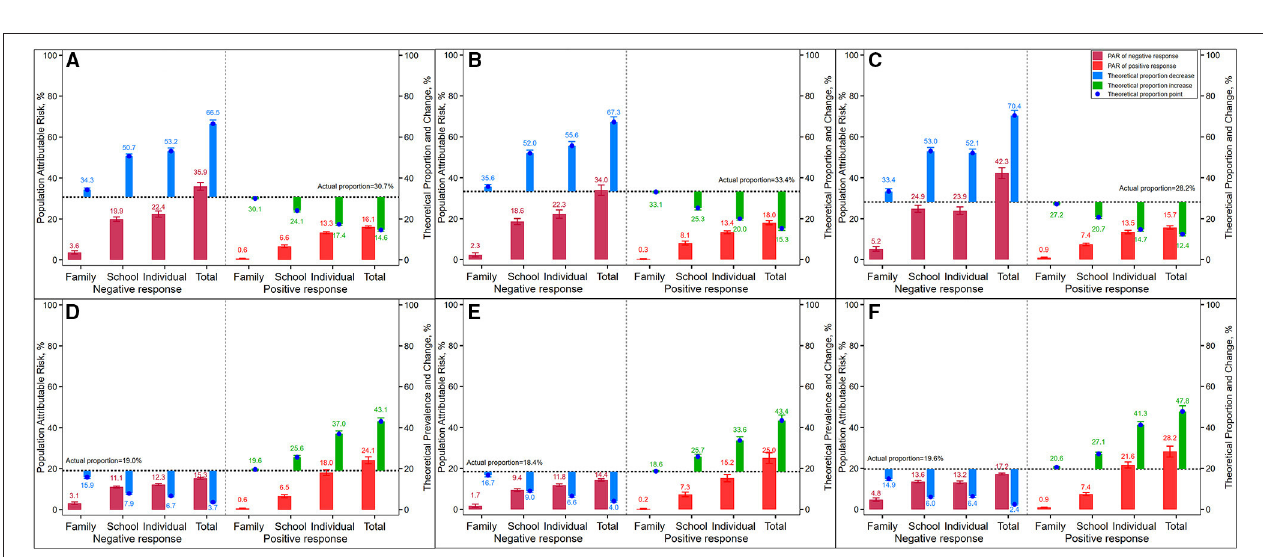
FIGURE 5 | The population attributable risk and theoretical proportions of low- and high-PFI levels (dependent variables) and its theoretical changes to actual levels if 20 related influencing factors (independent variables) were controlled. (A) Total low PFI level. (B) Boys low PFI level. (C) Girls low PFI level. (D) Total high PFI level. (E) Boys high PFI level. (F) Girls high PFI